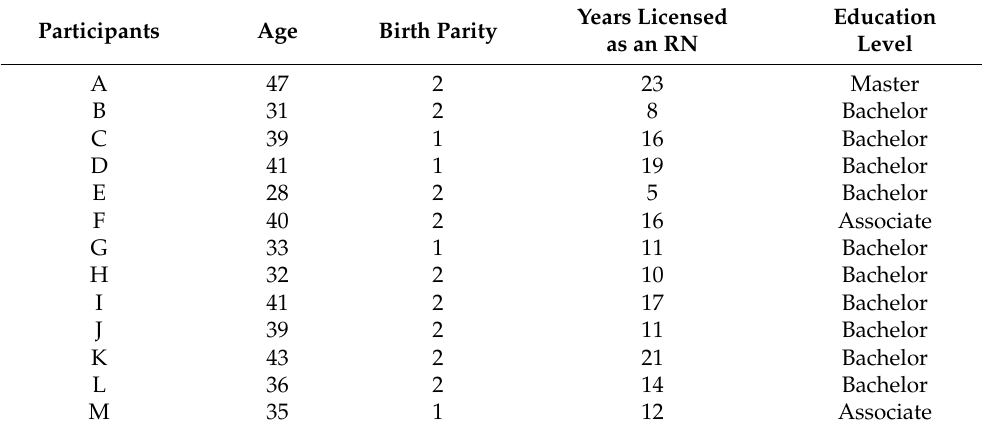
Table 2. Characteristics of